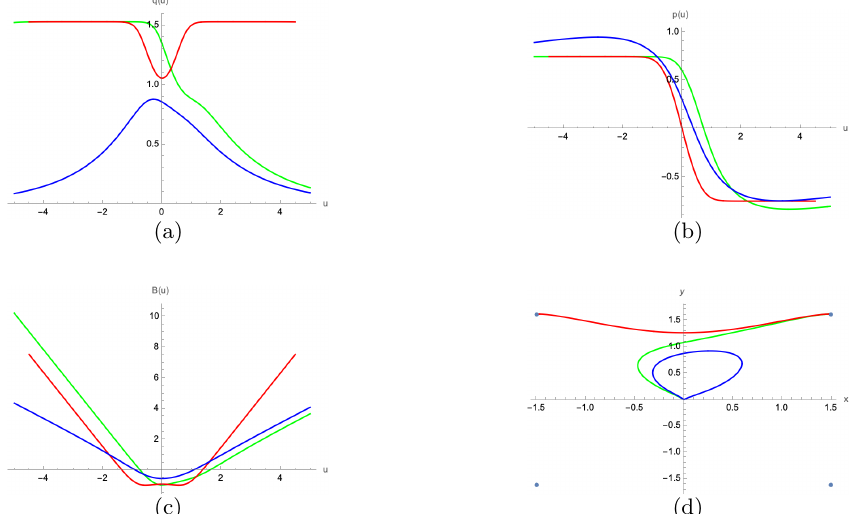
Figure 5. Truncation 3: (a)-(c) plots of p, q, B respectively, (d) parametric plot of the Janus flow in the x, y variables, the N = (4 , 4) vacuum is at the origin and the dots denote the locations of the N = (1 , 1) vacua. Blue: Janus between N = (4 , 4) vacua, red: Janus between N = (1 , 1) vacua, green: RG-Janus between N = (4 , 4) and N = (1 , 1) . We have set α = 1 . 2 for these